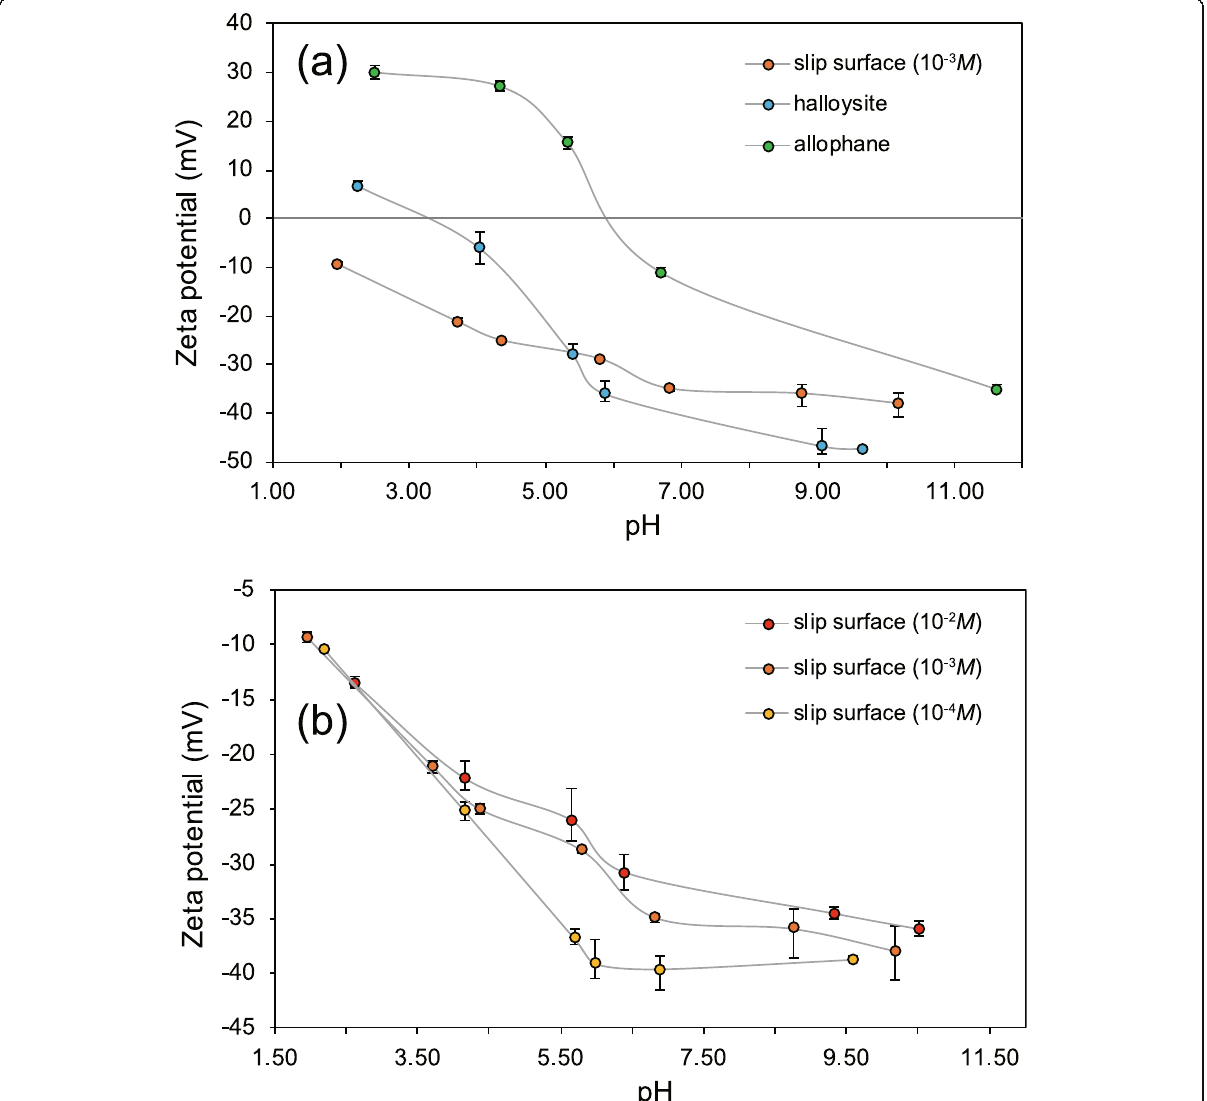
Fig. 8 Results of electrophoretic analysis. (a) Zeta potentials with respect to pH. Results for reference halloysite and allophane samples are included for comparison. (b) Zeta potentials with respect to pH at different solute concentrations. Error bars denote the range of three repeated